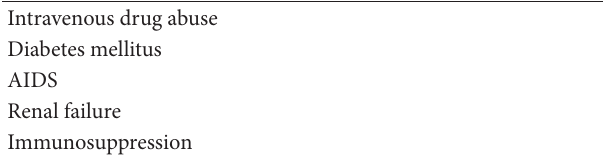
Table 1: Primary iliopsoas abscess can occur in [17].